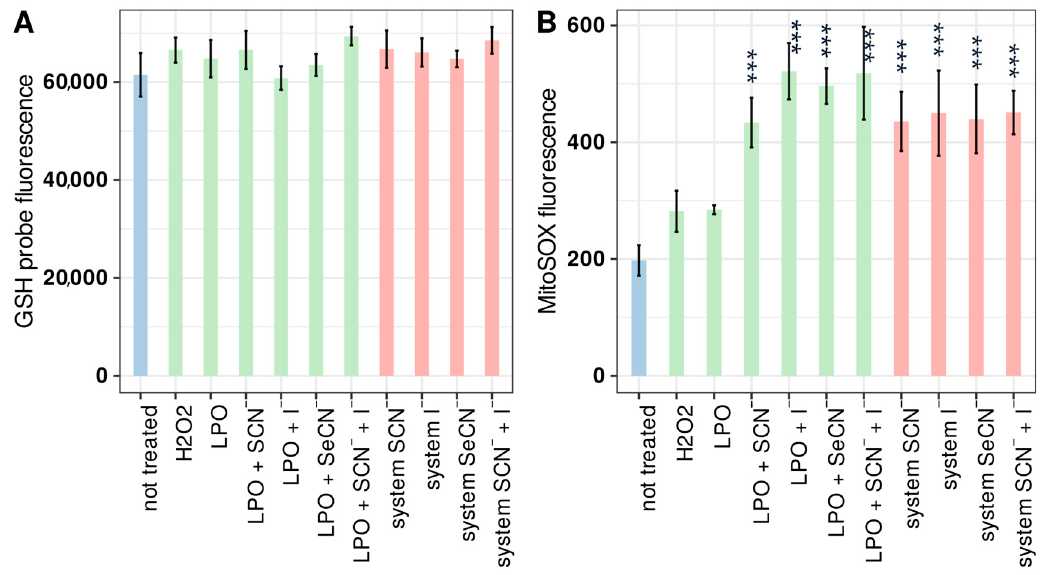
Figure 3. Influence of tested systems on ( A ) intracellular glutathione and ( B ) mitochondrial superoxide production in HGFs. In both cases, the bar describes the mean relative fluorescence of the cells after staining, which is proportional to the intracellular GSC concentration ( A ) and superoxide production ( B ). Colours indicate sample types where (i) blue denotes the control, (ii) green denotes an inactive LPO system (enzyme + (pseudo)halide), and (iii) red denotes an active LPO system. Asterisks indicate a statistically significant difference between a tested group and the control in the post hoc Tukey’s test—*** p < 0.001.